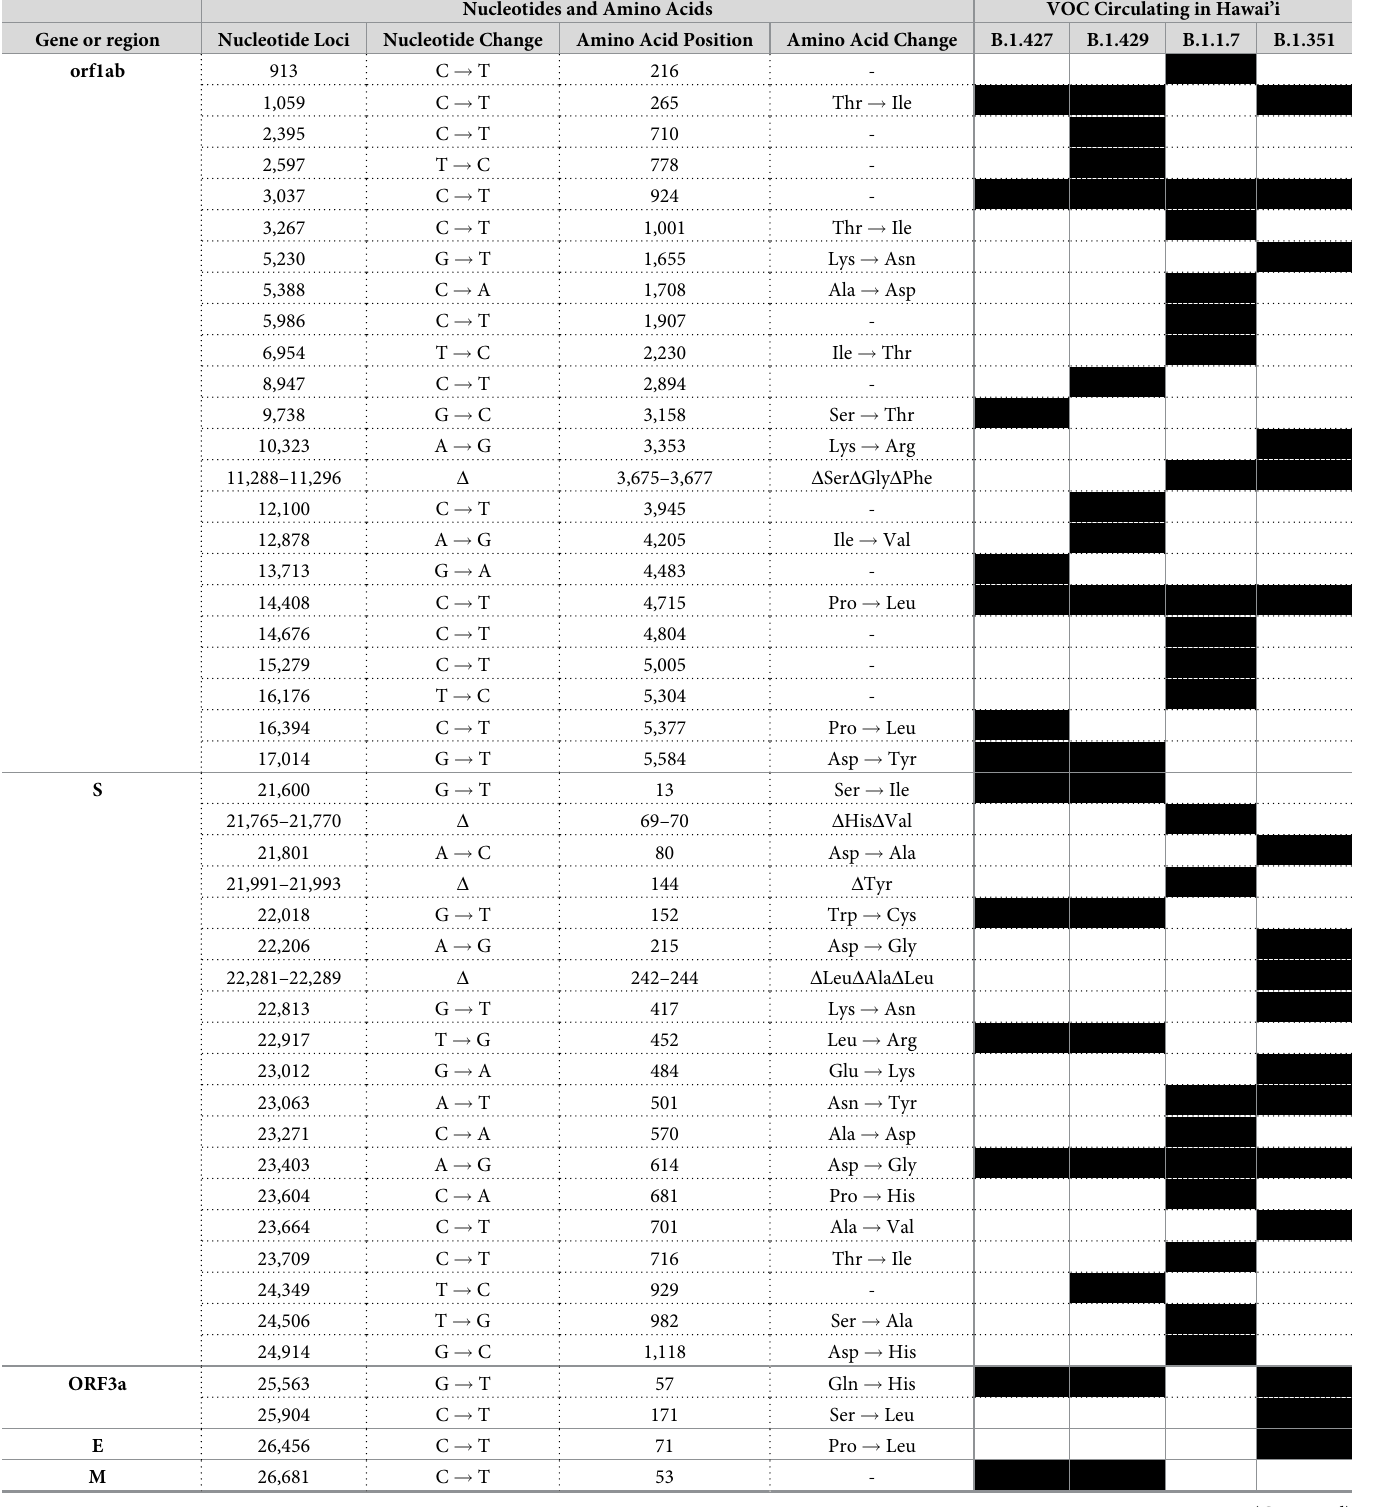
Table 2. Single nucleotide polymorphisms, amino acid substitutions, and deletions among SARS-CoV-2 variants of concern circulating in Hawai’i. Nucleotides and Amino Acids Gene or